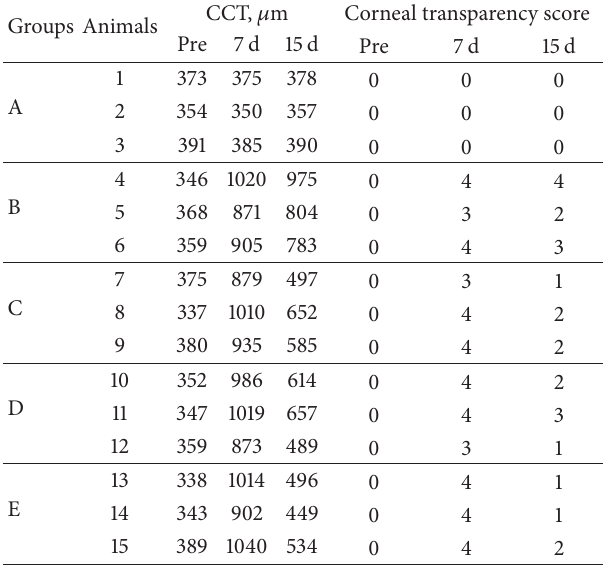
Table 1: Treatment protocols for the eyes in each group. Groups Eyes Descriptions